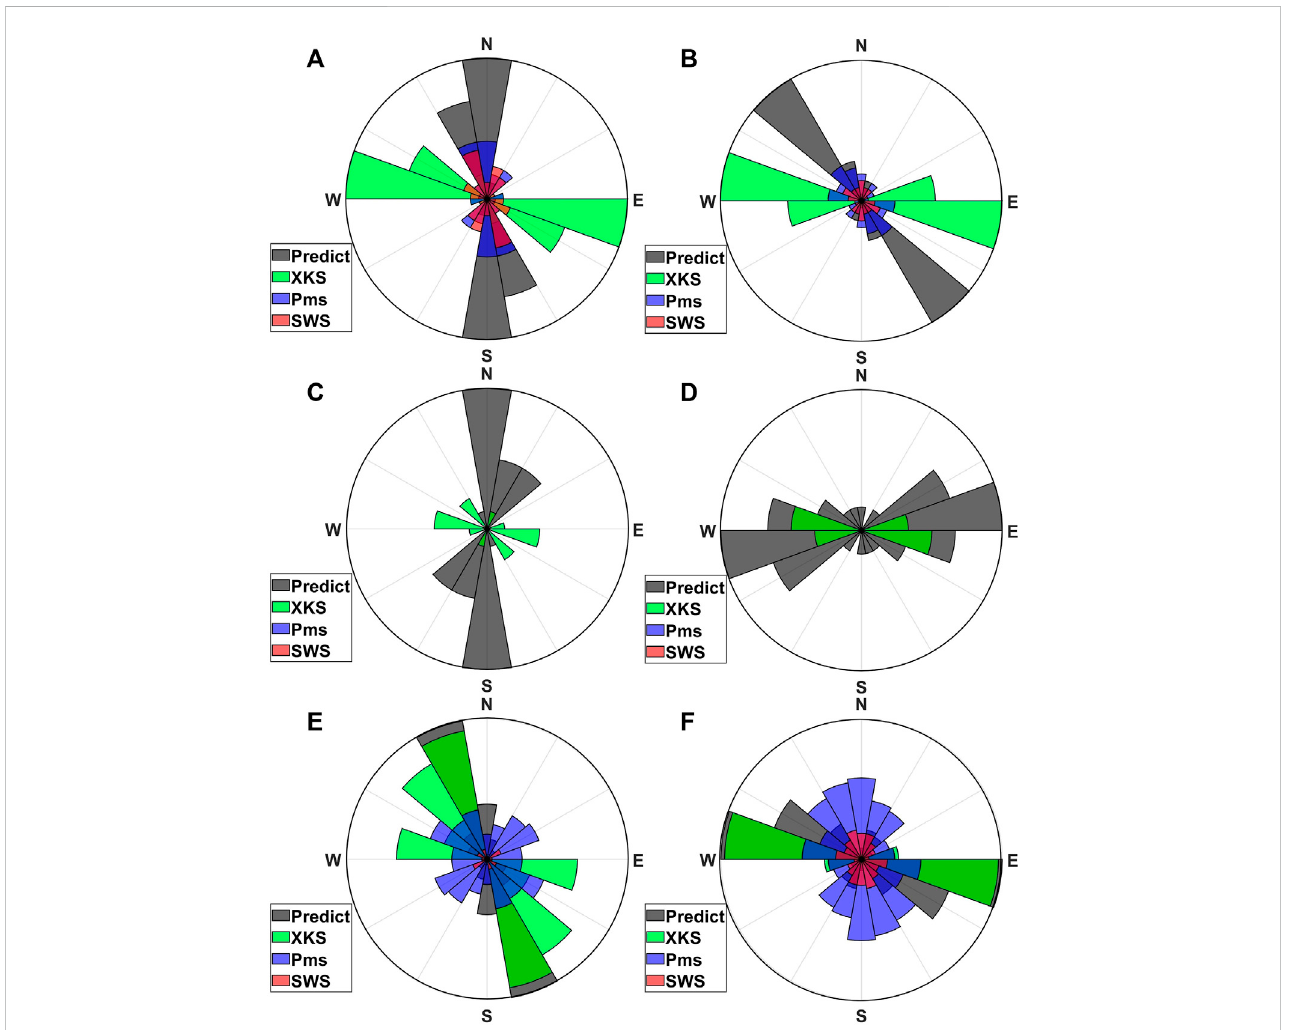
FIGURE 8 Rose diagram of the fast axis direction (A – F) of the predicted (black bars) and the observed data from XKS phase data (green bars), Pms phase data (blue bars) and local events (red bars) at different areas marked in Figure 7 and Figure 9 by orange boxes. The depth range of the predicted fast axis direction is the same as the corresponding depth range of Figure 7 and Figure